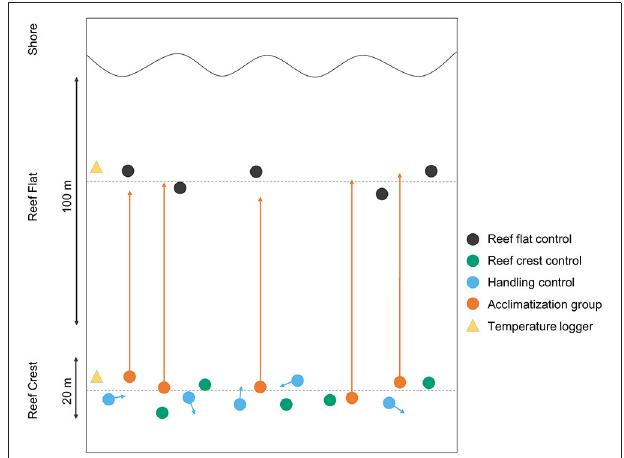
FIGURE 1 | A schematic diagram of the experimental set up, showing the position of individual coralline algae on Suleman Reef ( n = 5 per group). Arrows indicate the direction and place of translocation for both the handling and acclimatization